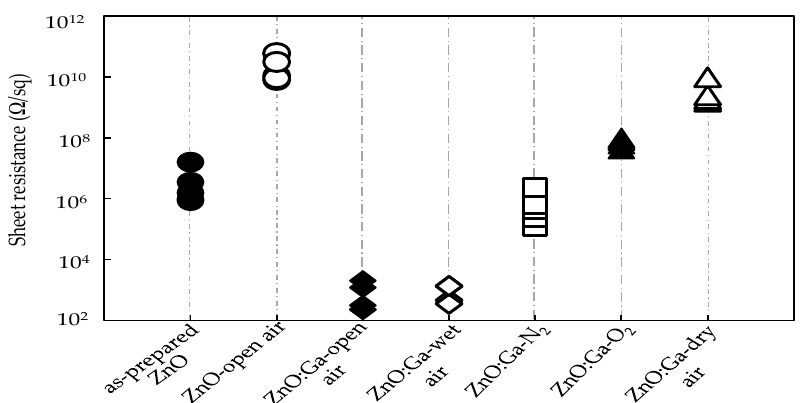
Figure 4. Resistivity distribution graph for each sprayed NP layer. Table 1. Average sheet resistance of each sprayed NPs layer:. Samples